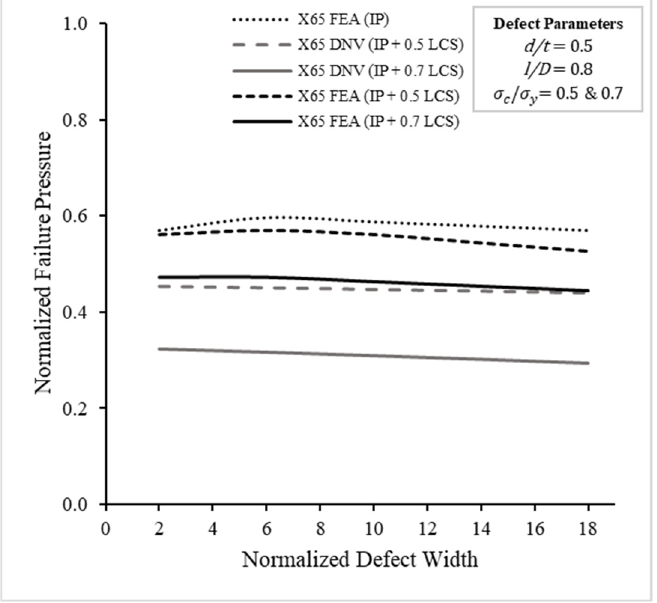
Figure 12 . FEA and DNV predictions of normalized failure pressure predictions versus normalized defect width with 0.5 and 0.8 normalized longitudinal compressive stress.